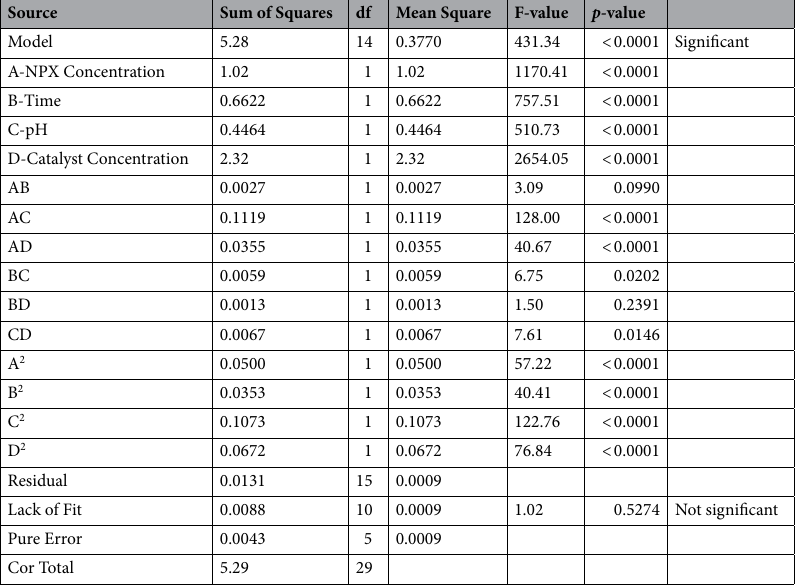
Table 5. ANOVA results for the quadratic